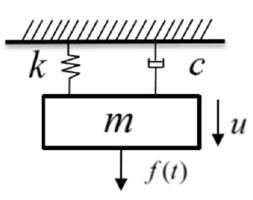
Figure 1. Single-degree-of-freedom system.